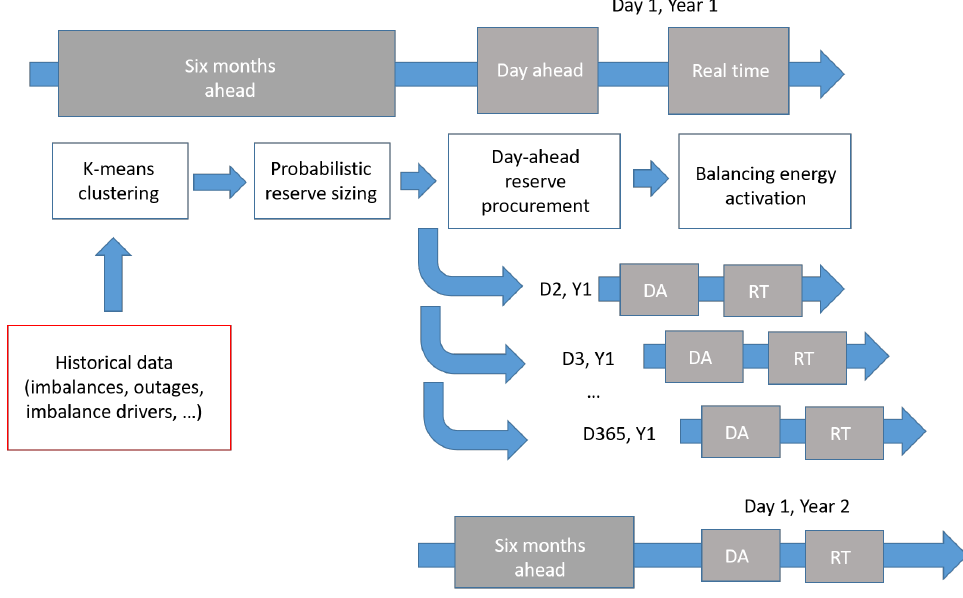
Figure 4. Timeline of a probabilistic dimensioning procedure, where the training of the probabilistic dimensioning algorithm takes place once a year based on the data of the previous